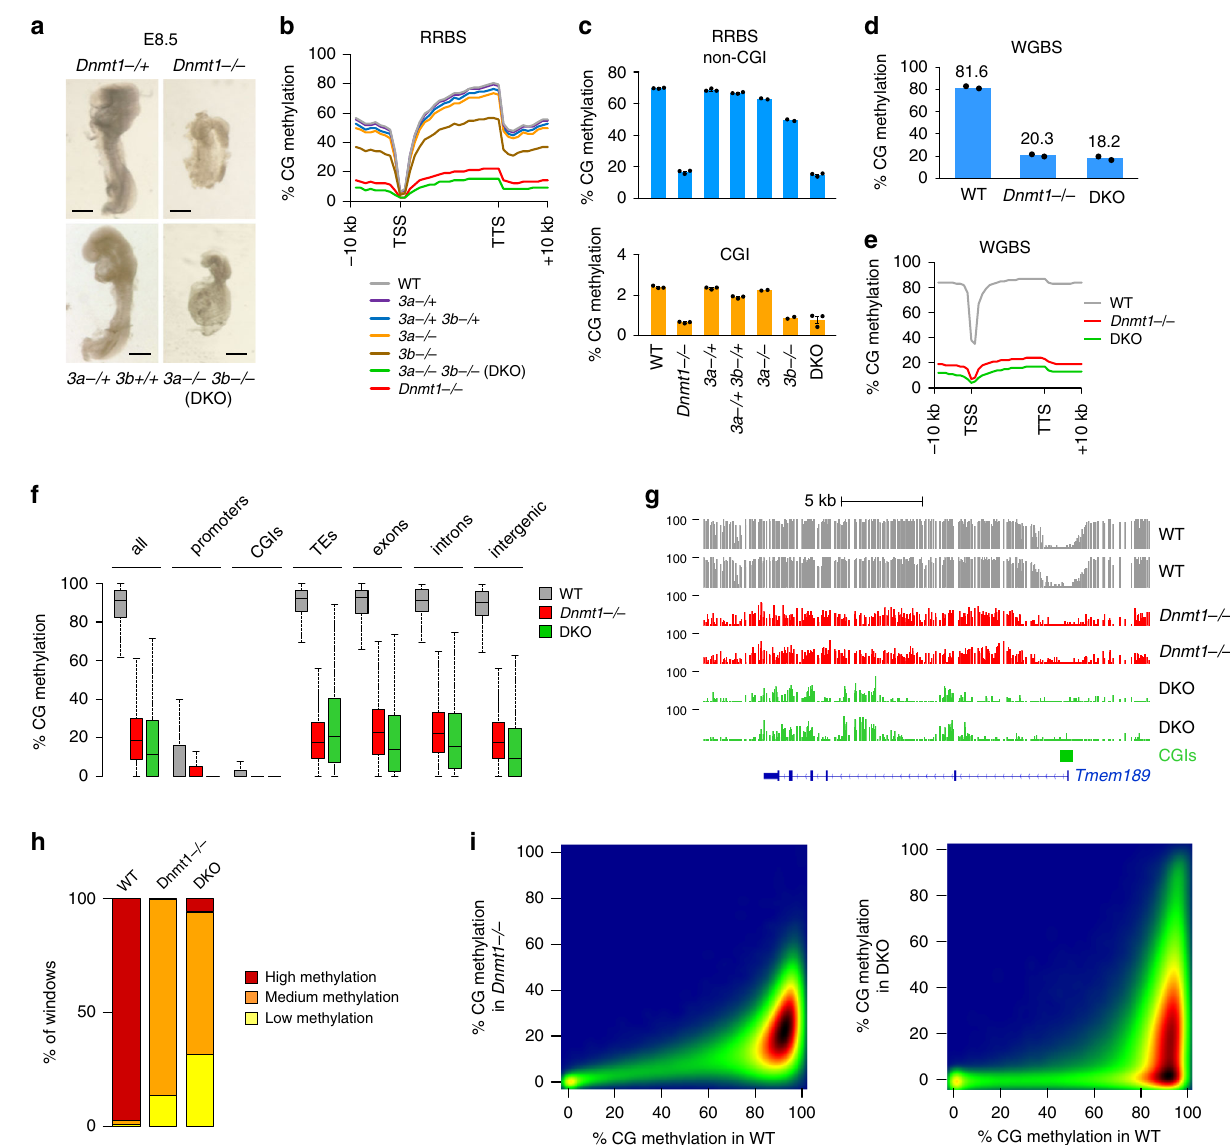
Fig. 1 Methylome pro fi ling in Dnmt mutant embryos. a Images of Dnmt1 − / − and DKO embryos dissected at E8.5 compared with littermate heterozygous controls (which are identical to WT). Black bars: 300 μ m. b Average distribution of CG methylation over RefSeq genes and 10 kb fl anking sequences calculated from the RRBS data in E8.5 embryos. Our previous data from single Dnmt3a − / − and Dnmt3b − / − embryos 7 was included for comparison. TSS transcription start site, TTS transcription termination site. c Average methylation of CGs located outside of CpG islands (non-CGI, top) or within CpG islands (CGI, bottom) measured by RRBS in Dnmt mutant and control embryos (mean ± SEM, n = 3 independent embryos for all genotypes except n = 2 for Dnmt3a − / − and Dnmt3b − / − ). d Bar plot representing the average CG methylation level measured by WGBS in WT, Dnmt1 − / − and DKO E8.5 embryos (mean of n = 2 independent embryos). e Metaplots of CG methylation levels in RefSeq genes and 10 kb fl anking sequences calculated from the WGBS data in WT, Dnmt1 − / − and DKO E8.5 embryos. f Boxplots of CG methylation levels measured by WGBS in different genomic features in WT, Dnmt1 − / − and DKO E8.5 embryos. In the boxplots the line indicates the median, the box limits indicate the upper and lower quartiles and the whiskers extend to 1.5 IQR from the quartiles. g Example of genome browser view of WGBS methylation pro fi les in two independent replicates of WT, Dnmt1 − / − and DKO E8.5 embryos. Each track shows the percent methylation of individual CpGs between 0 and 100%. CpG islands (CGIs) depicted by green rectangles and RefSeq gene annotations are shown below the tracks. h Stacked bar graph representing the proportions of genomic windows (1 kb) with high (>50%), medium (10 – 50%), and low (<10%) CG methylation in WT, Dnmt1 − / − and DKO embryos. i Density scatter plots comparing WGBS methylation scores in 500 bp windows between WT, Dnmt1 − / − and DKO E8.5 embryos. The density of points increases from blue to dark red. In f , h , i , values are the average of n = 2 independent embryos. Source data are provided as a Source data fi